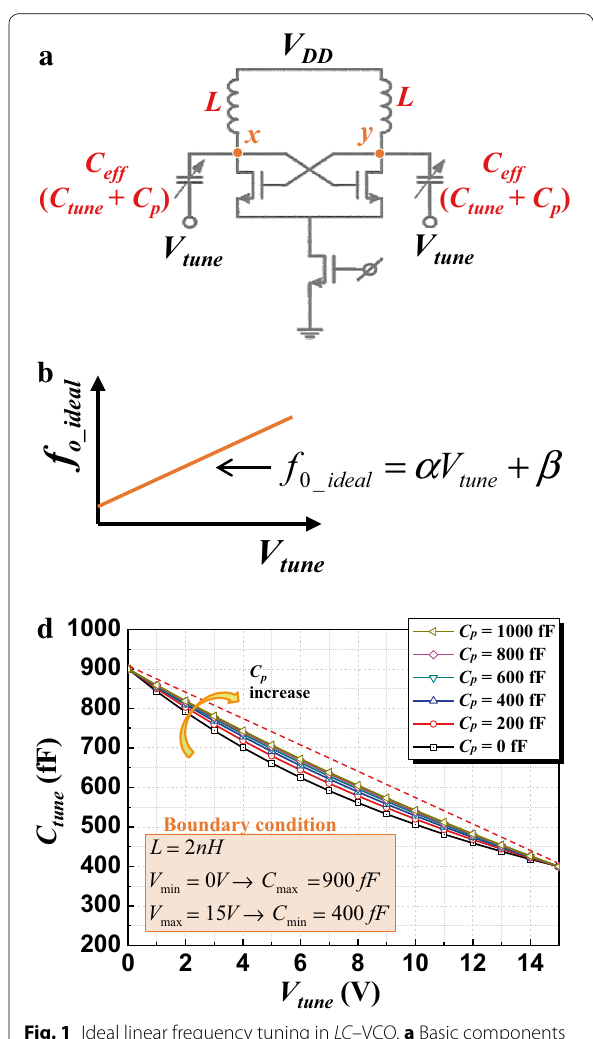
Fig. 1 Ideal linear frequency tuning in LC –VCO. a Basic components of the LC –VCO circuit, b ideal linear output frequency tuning char‑ acteristic, c required C tune– V tune response to achieve linear frequency tuning, with various parasitic capacitances, C